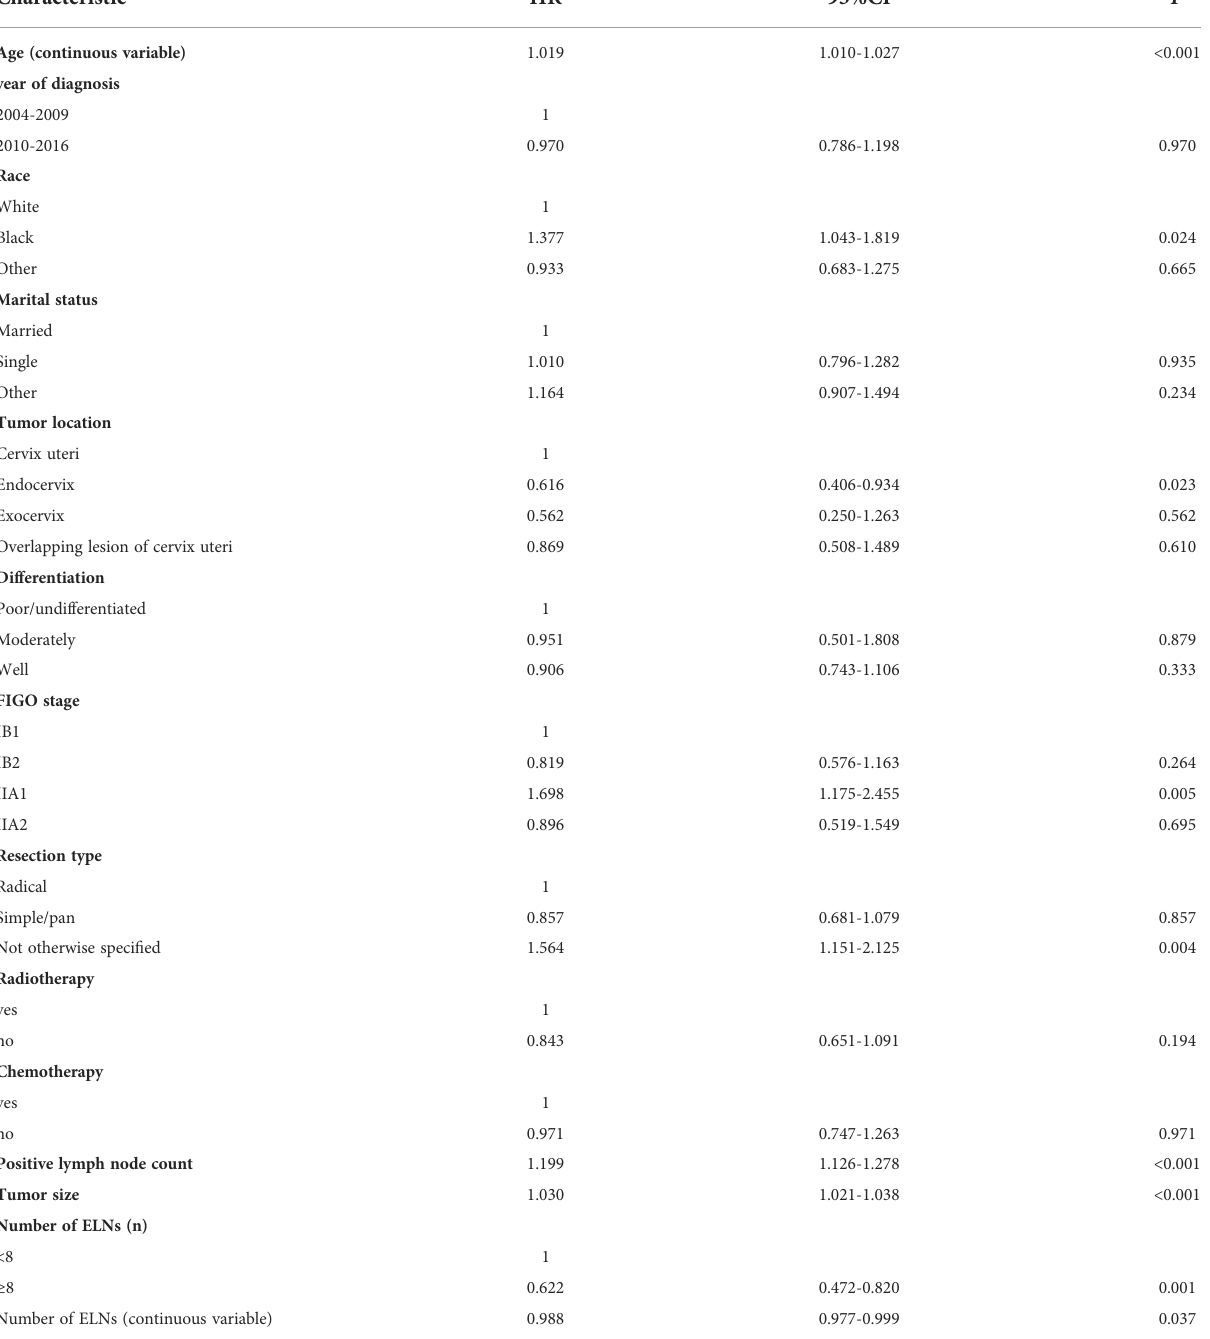
TABLE 3 Multivariable Cox proportional hazard regression analyses of factors associated with overall survival of all